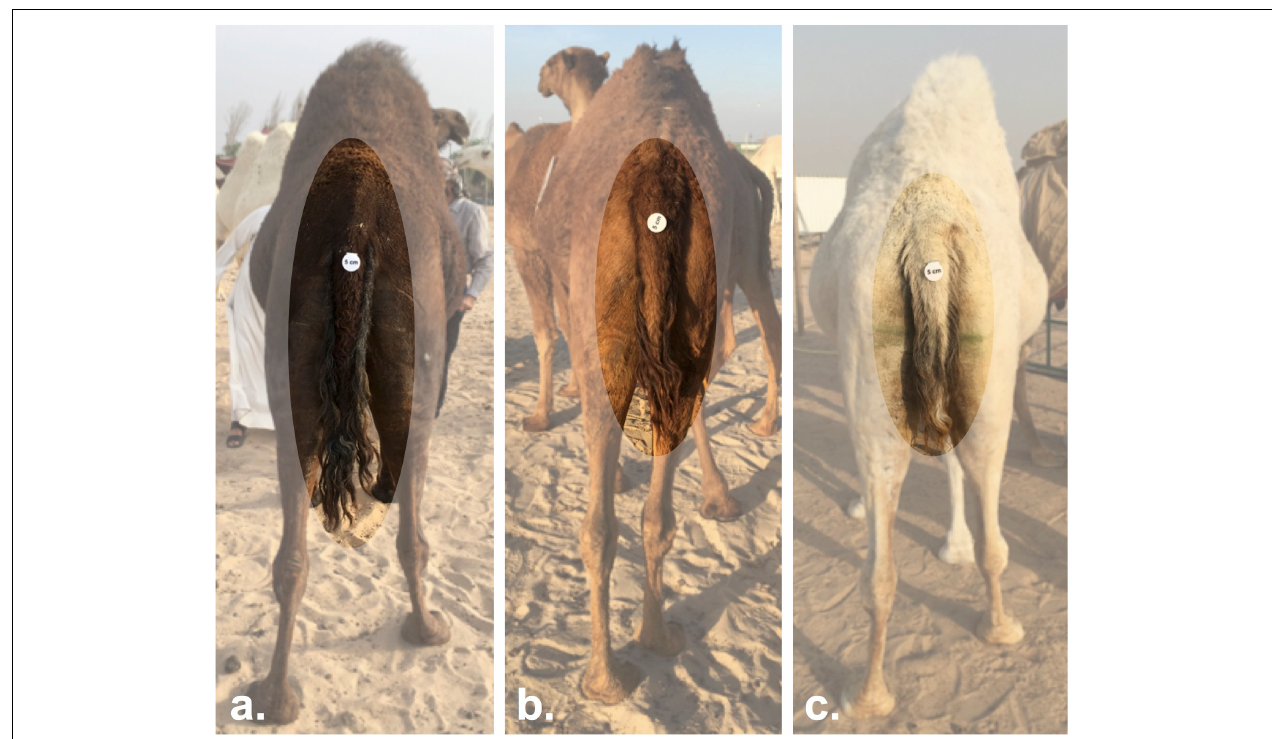
FIGURE 5 | Tail length variation between Mezayen camel breeds. (a) Majaheem camels are characterized by long tails with a narrow tail-base. (b) Shaele, and (c) Waddah camels, which represent the Malaween breeds, display short-tails with wide tail-bases. The white disks on the tail are reference scales (five centimeters in diameter). Images were extracted from Cdrom Archive photos (collected by the